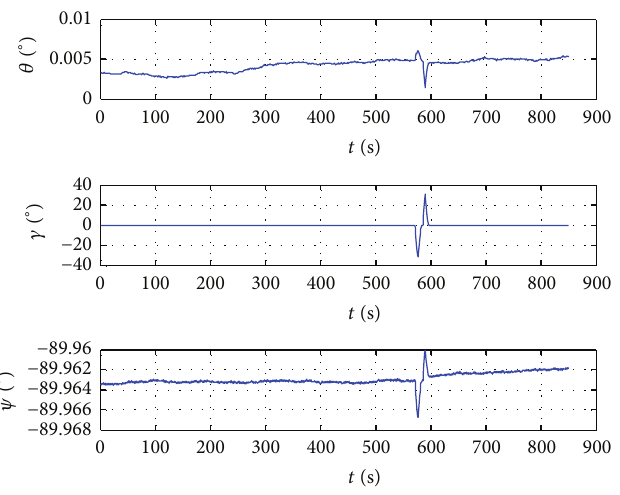
Figure 4: The change of attitude angle of semiphysical